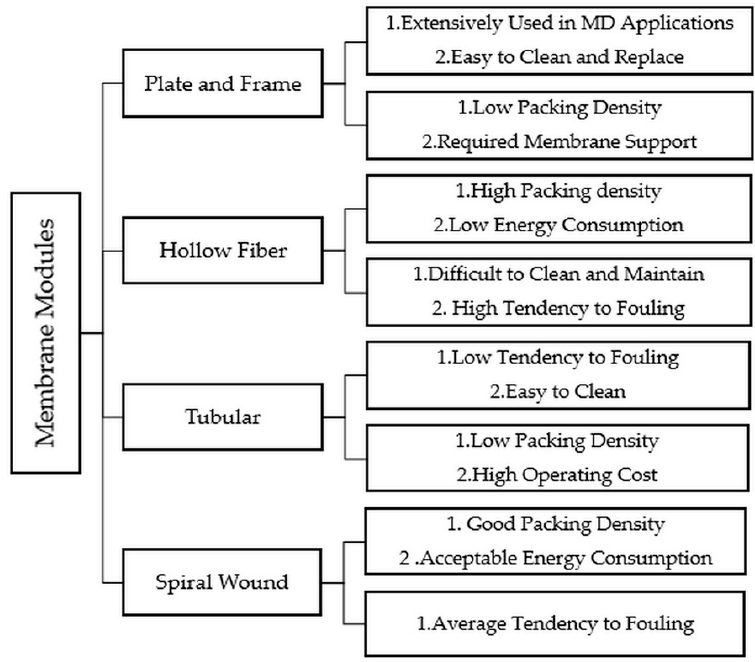
Figure 2. Advantage and disadvantages of membrane modules. Table 3. Commercial membranes applied in MD (membrane thickness, δ ; porosity, ε ; liquid entry pressure of water, LEPw).